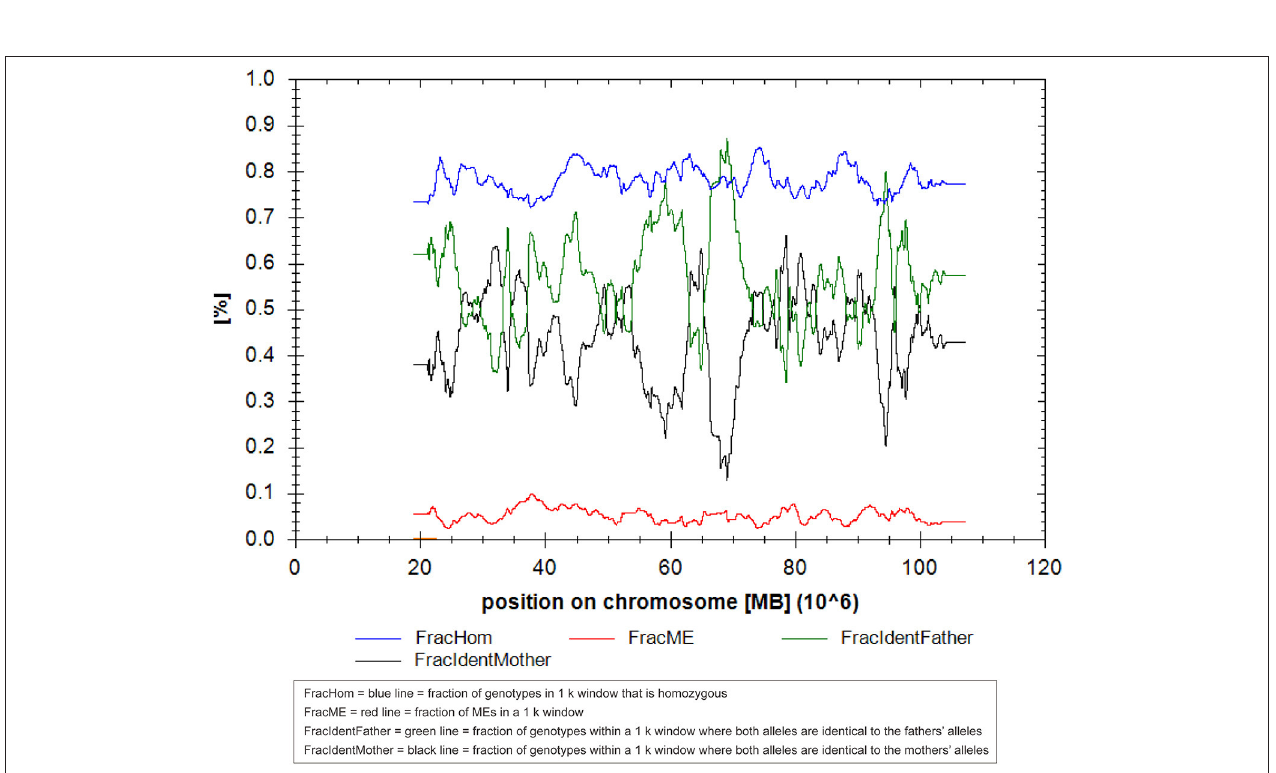
FIGURE 2 | The result of the UPDtool in parent–child triols in this case of upd(14)pat using single-nucleotide polymorphism (SNP) microarray.